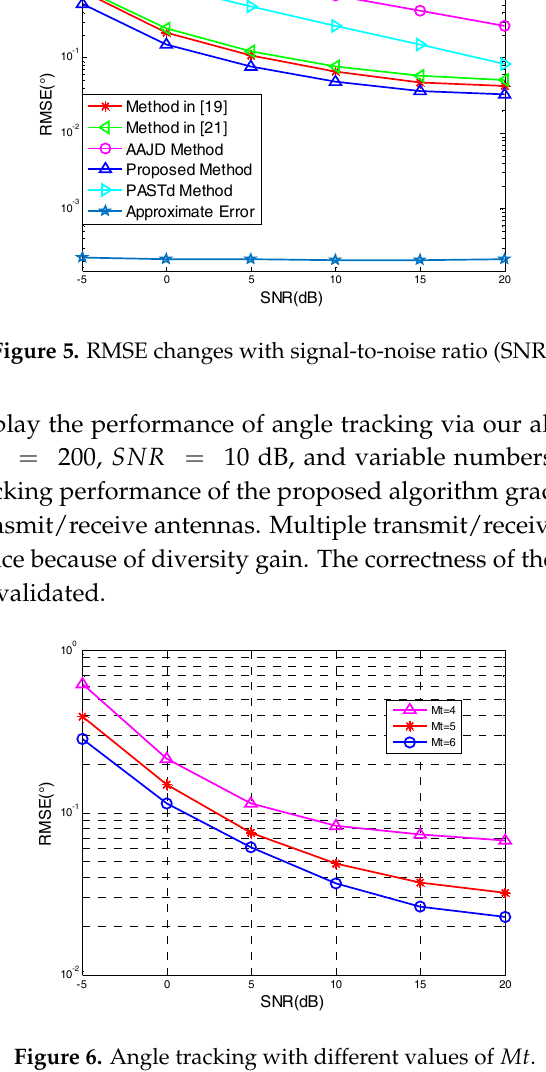
Figure 7. Angle tracking with different values of Mr .